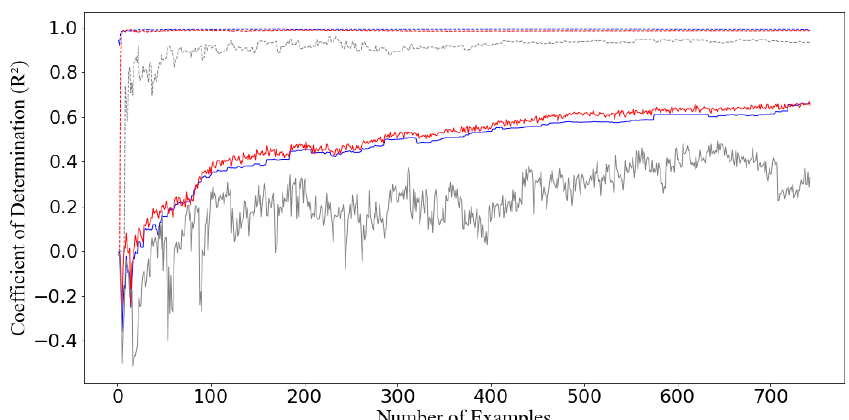
Figure 4. Performances on training (solid lines) and test data (dashed lines) of optimized support vector regressor (blue), random forest regressor (red), and decision tree regressor (grey) evaluated by the coefficient of determination ( R 2 ).